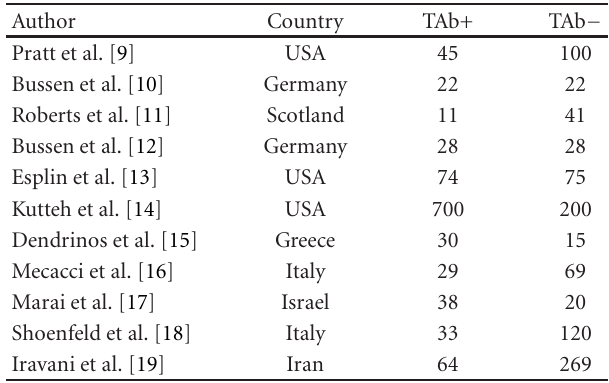
interest, the three negative studies were all performed in the United States.